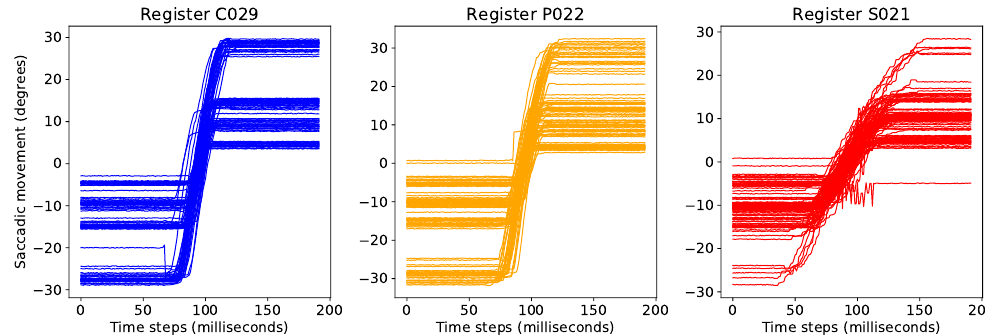
Figure 1. Representation of all saccades from a register in class control (C029), one presymptomatic (P022) and sick